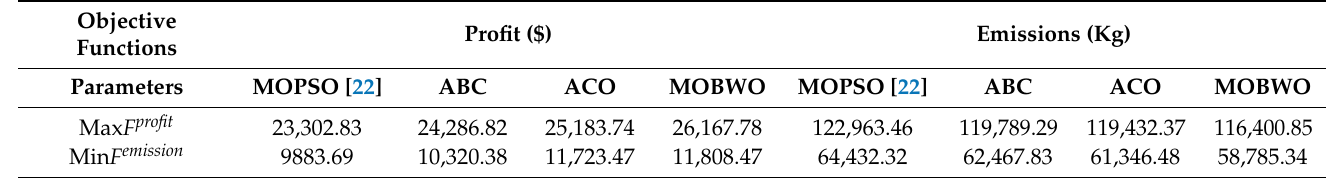
Table 10. Comparison of multi-objective with published and proposed